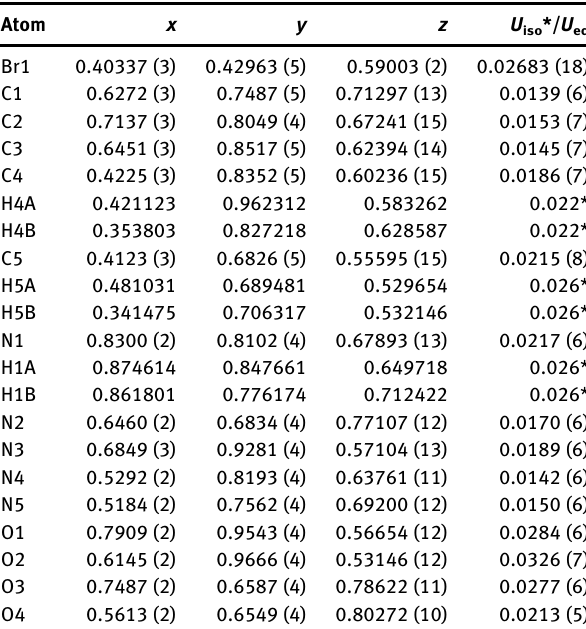
Table  : Fractional atomic coordinates and isotropic or equivalent isotropic displacement parameters (Å 